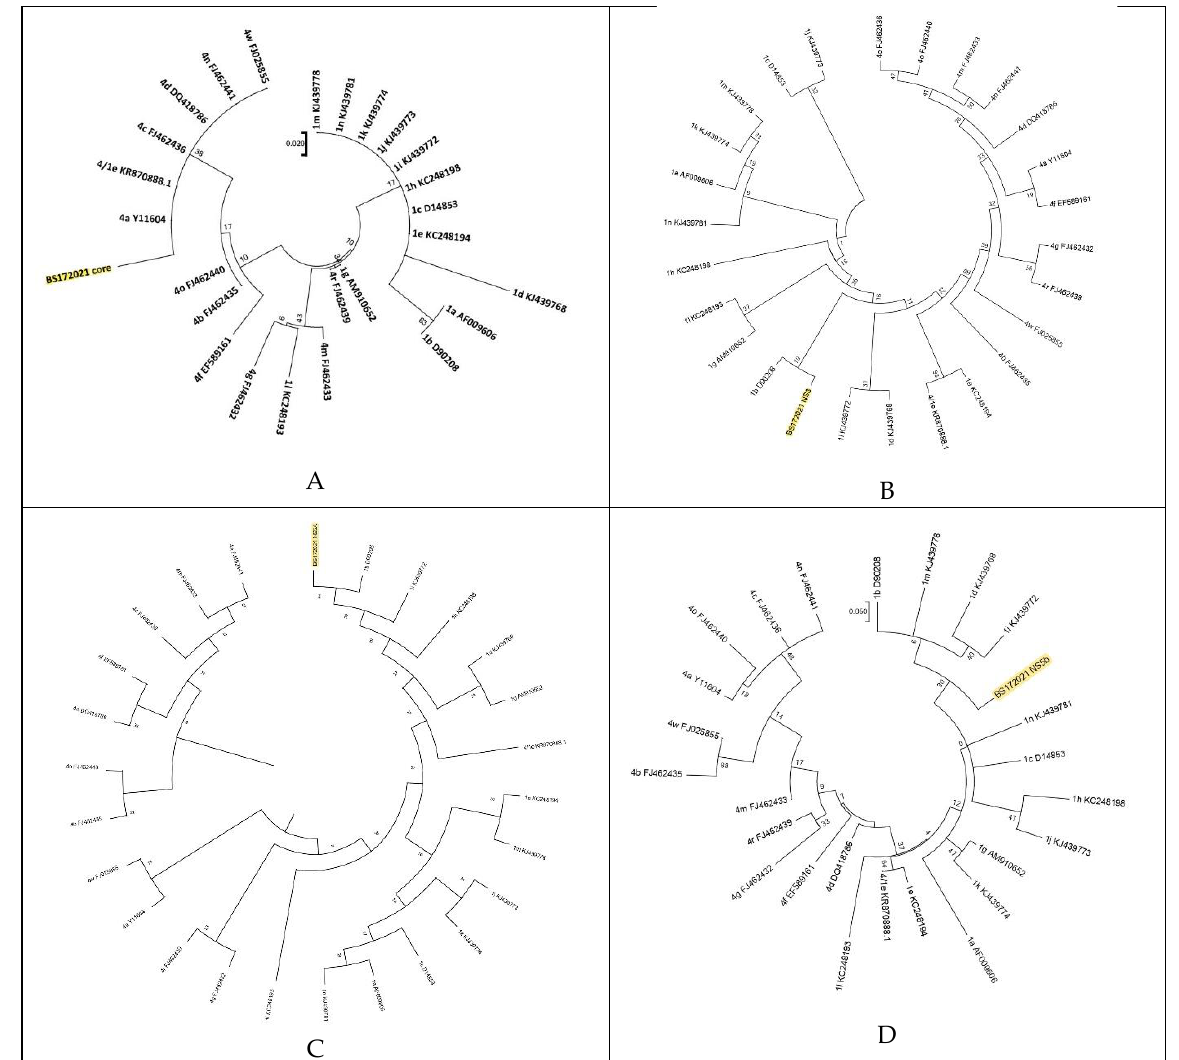
Figure 1. Phylogenetic tree analysis of a hepatitis C virus strain (BS172021) isolated from our patient compared with reference strains. The neighbor-joining tree was based on the core ( A ), NS3 ( B ), NS5A ( C ) and NS5B ( D ) sequences and the genetic distance was estimated using the Kimura 2 parameters model. The sequences identified in this study are marked in yellow. Reference sequences are labelled with their subtypes and accession numbers.